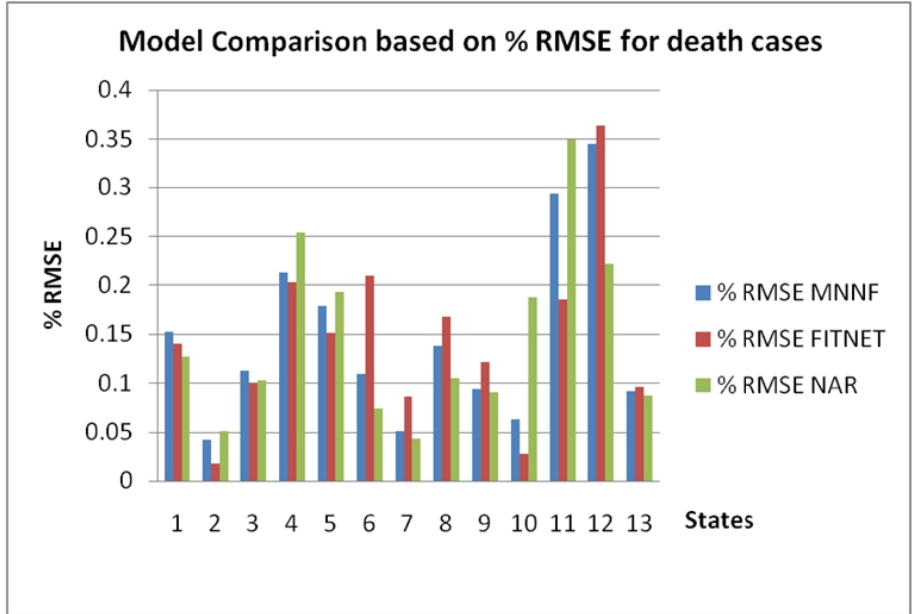
Figure 10. Comparison of % RMSE in death cases for the different models of NN for the 12 states and the Country of Mexico.